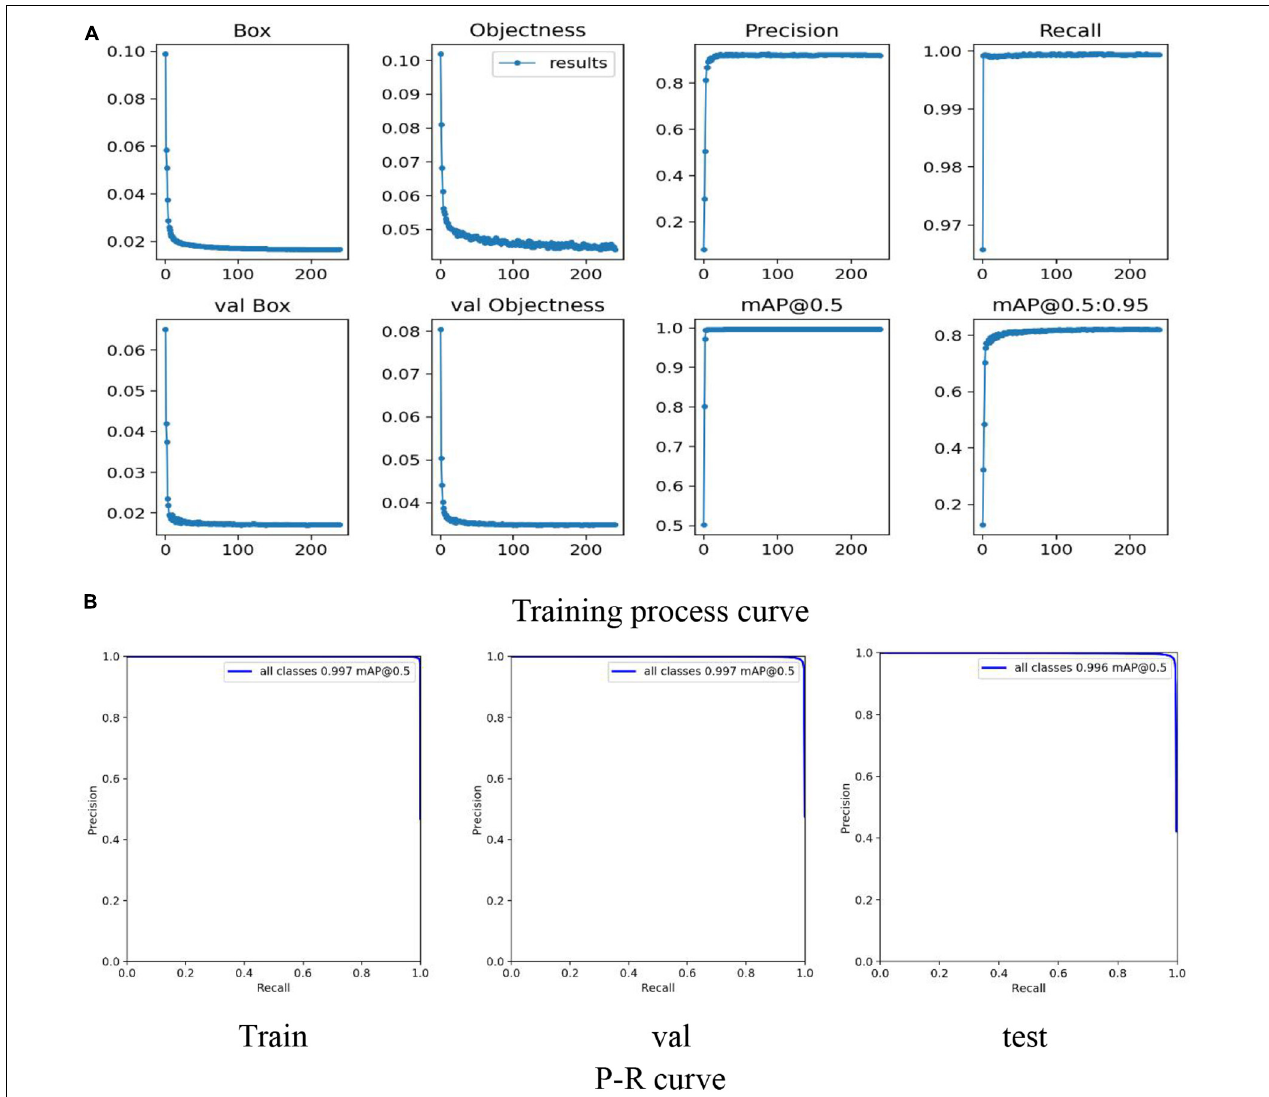
FIGURE 9 | Detection model training process based on YOLO-V5. (A) Mainly reflects the Loss, Precision, Recall, mAP curves in the training process and the Loss curve in the verification process. (B) Mainly reflects the P-R curve of training, testing and verification to judge the pros and cons of the model.